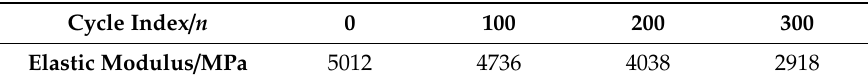
Table 10. Elastic modulus of the specimen.